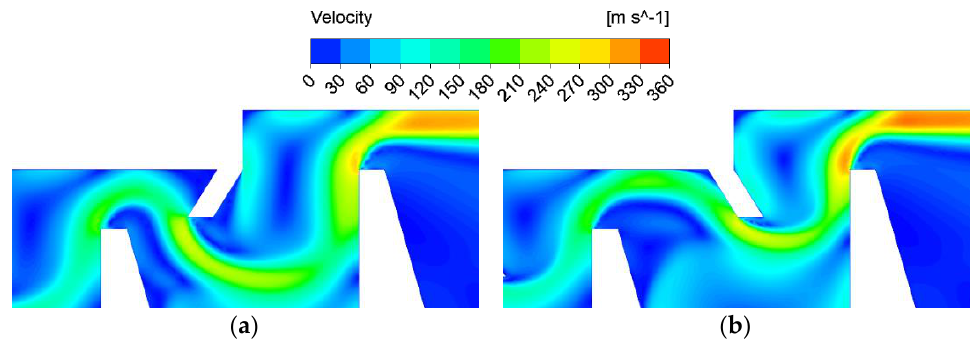
Figure 16. Velocity contour plots for various β (PR = 2.5, S/H = 1.0, t/K = 2.0). ( a ) β = 60°. ( b ) β = 120°.